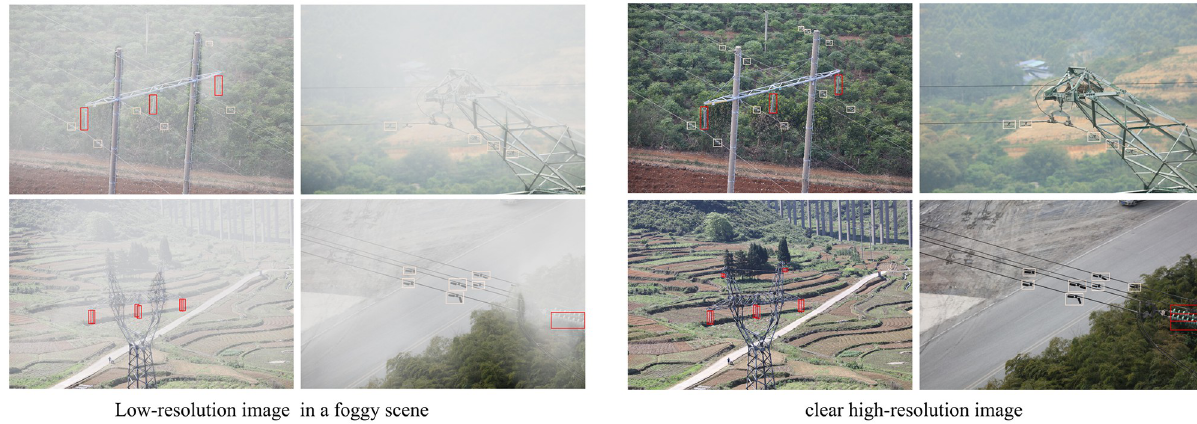
Fig 1. Low-resolution image (left) in a foggy scene and clear high-resolution image (right).